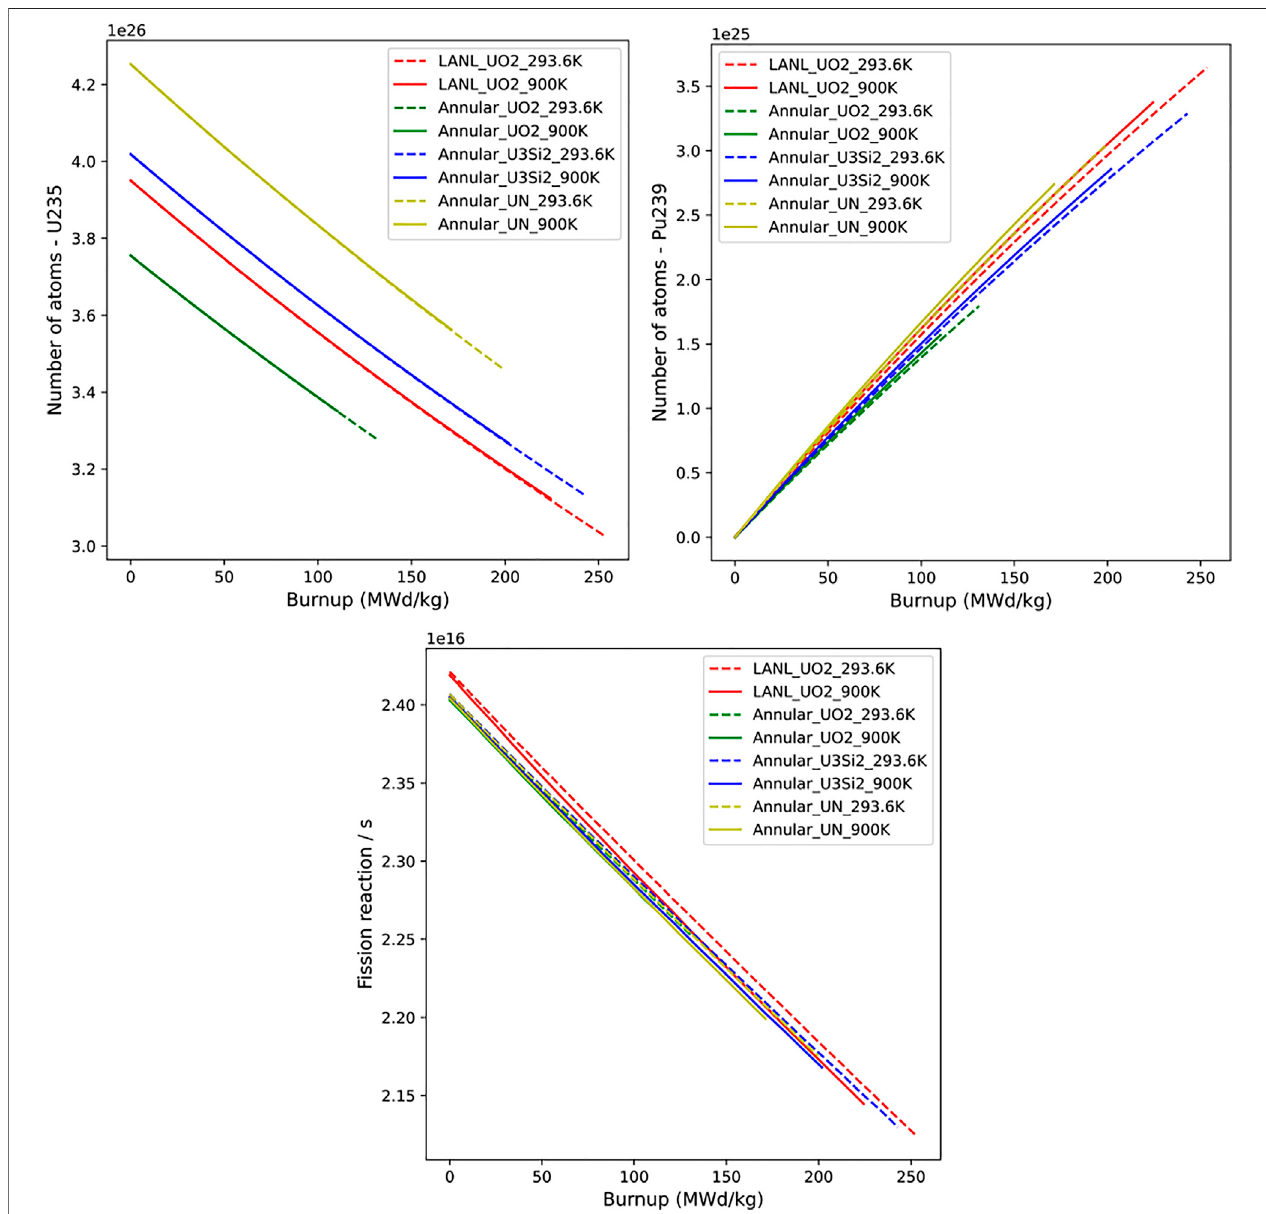
FIGURE 7 | Evolution of the number of U235, Pu239, and fi ssion rate with depletion for the whole life on case A.